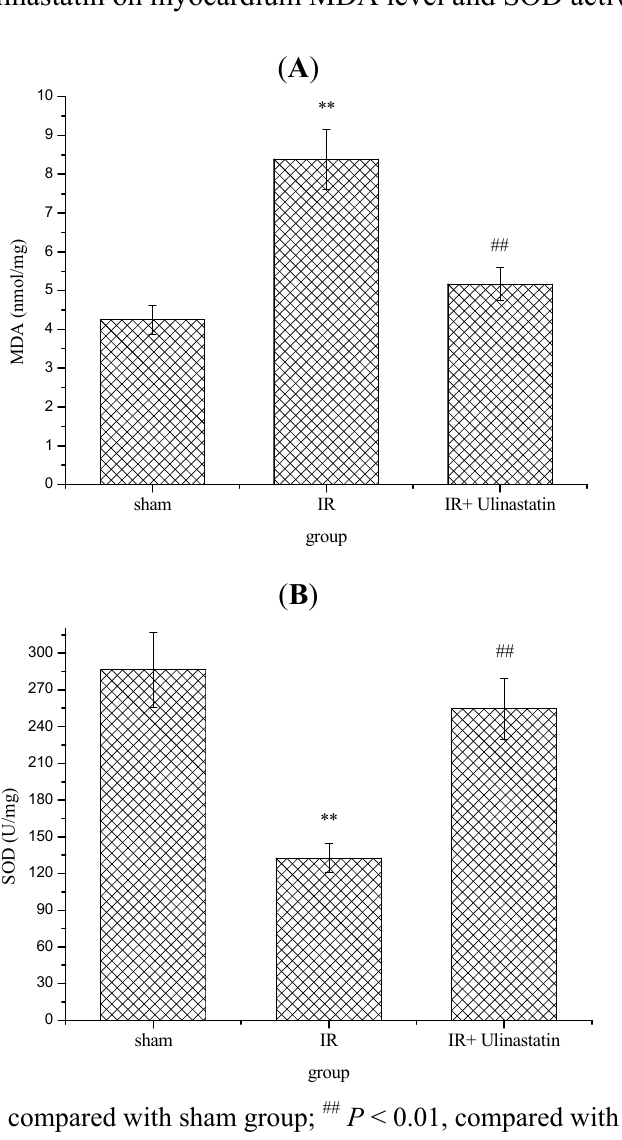
Figure 4. Effect of ulinastatin on myocardium MDA level and SOD activity in three